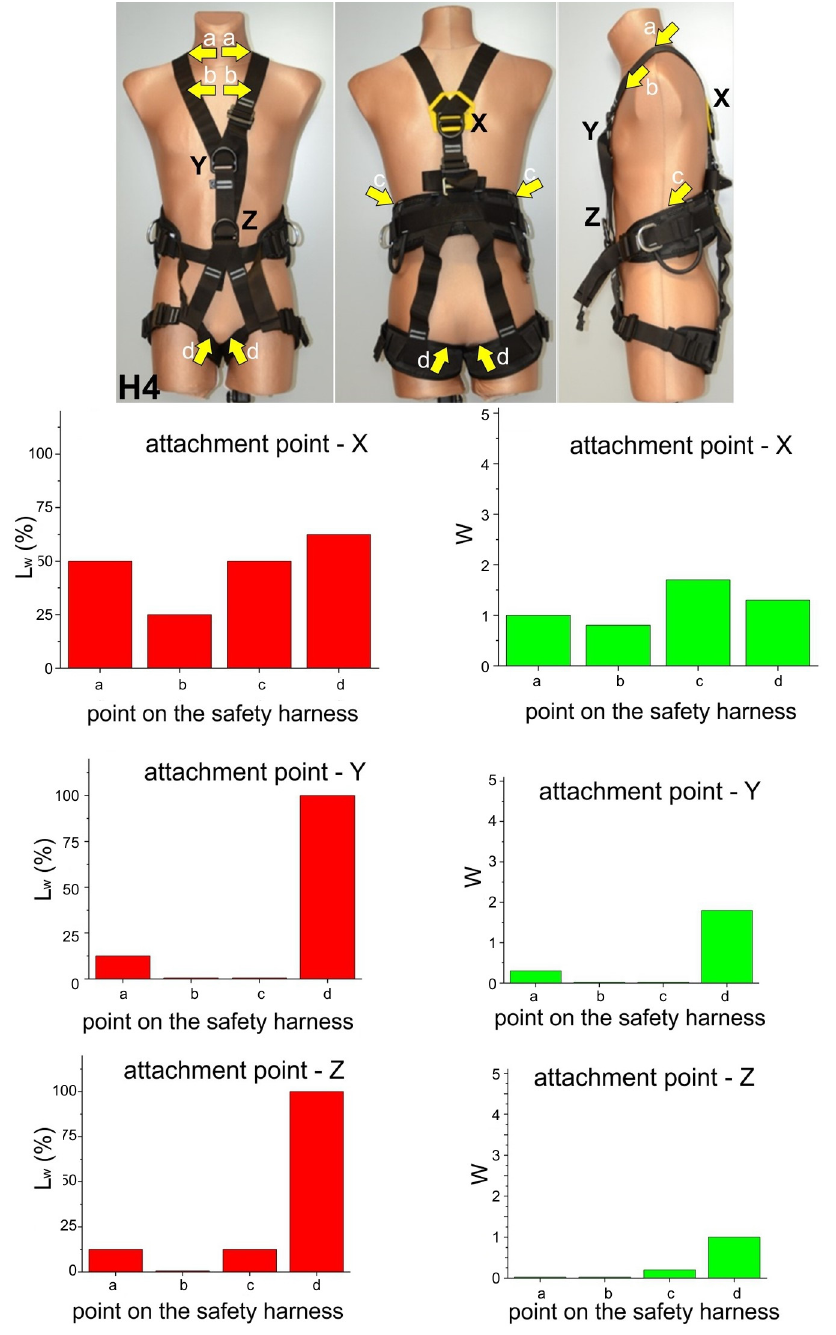
Figure 6. Test results for harness H4.